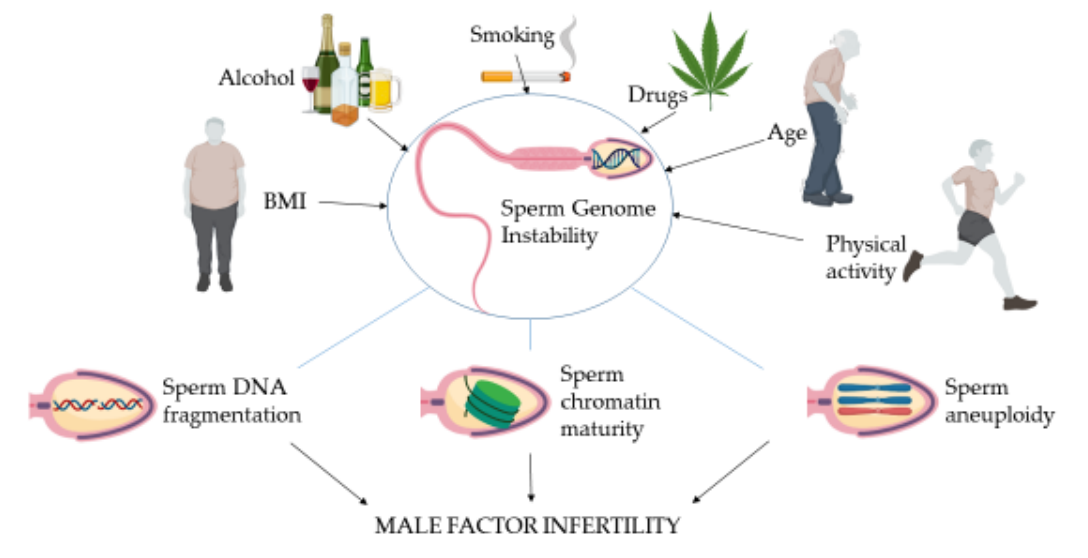
Figure 1. Schematic representation of the lifestyle factors analyzed and methods for genome instability assessment in male factor infertility. Figure created with BioRender.com.